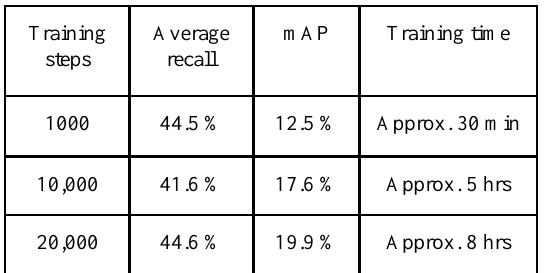
Table 2 . Indicators of model performance